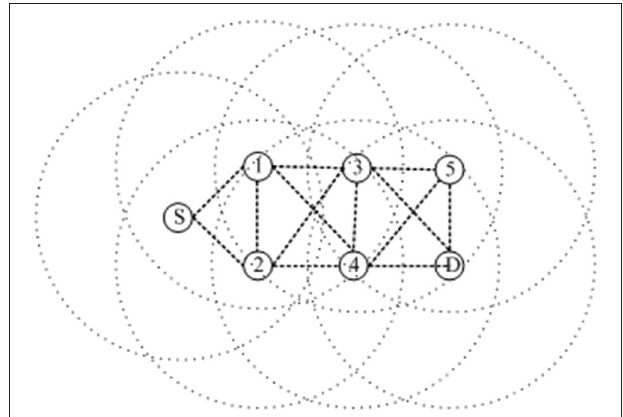
FIGURE 2 | Network schematic with five intermediate